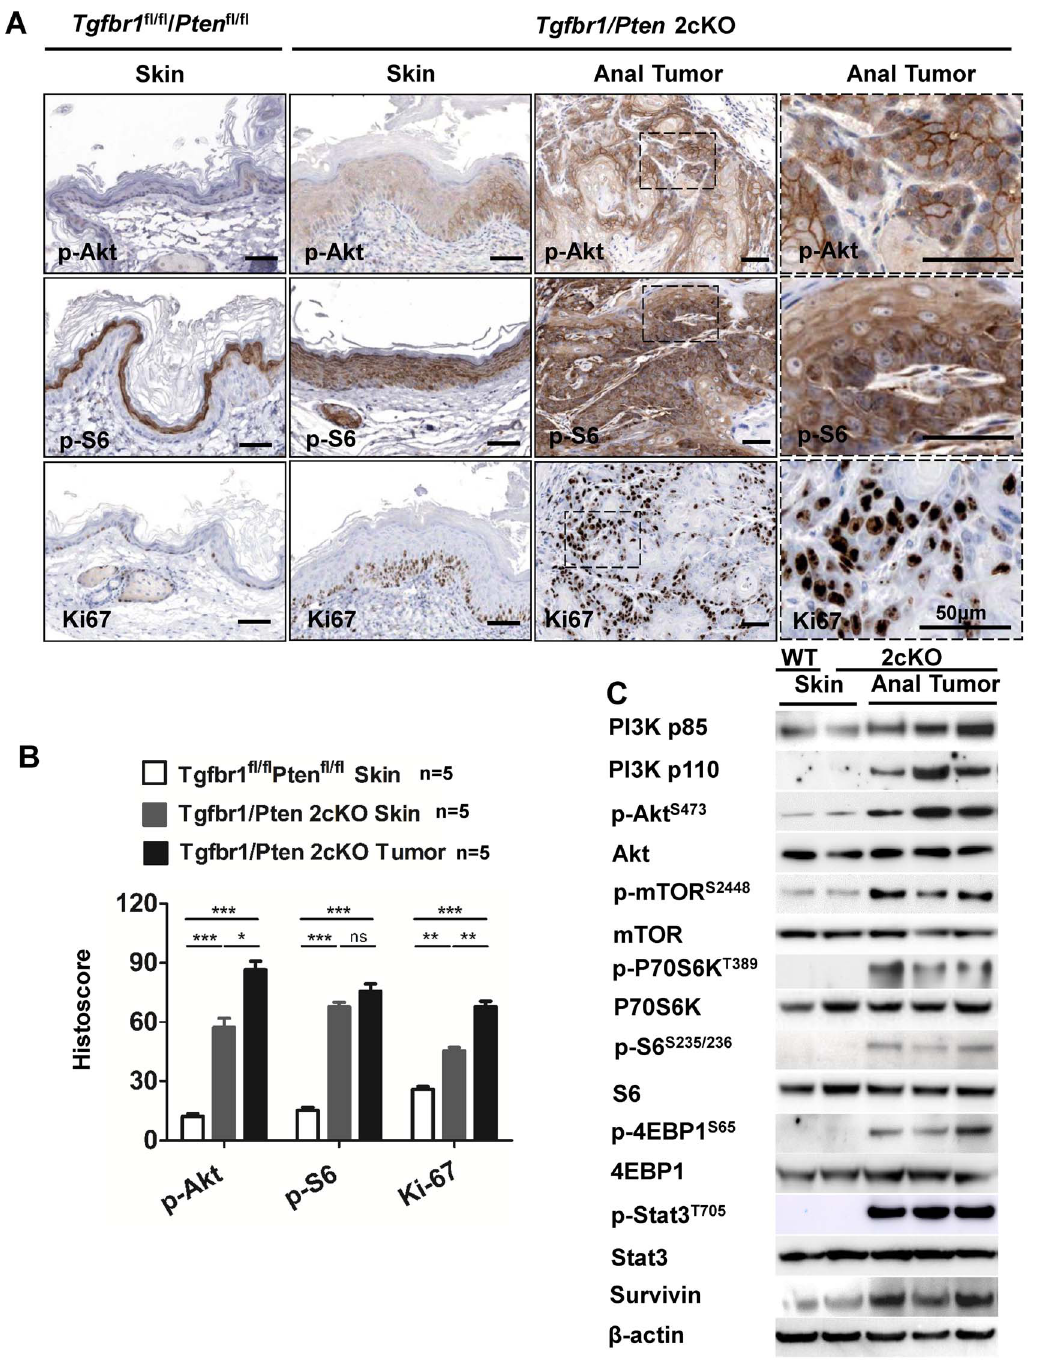
Figure 3. Activation of Akt/p-S6/Ki67 in Tgfbr1/Pten 2cKO ASCC. (A), immunostaining with specific antibodies indicates increased expression of p-Akt, p-S6, and Ki67 in Tgfbr1/Pten 2cKO mice ASCC (higher magnification is shown in the right most cloumn) as compared with Tgfbr1 flox/flox / Pten flox/flox skin (scale bars =50 m m). (B), the quantification of immunostaining shown in panel (A) presented as histoscore. Mean 6 SEM; *, P , 0.05; **, P , 0.01; ***, P , 0.001: One-way ANOVA. (C), Western blot analysis shows a significant increase in p-Akt, p-mTOR, p-P70S6K, p-S6, p-4E-BP1, and survivin in Tgfbr1/Pten 2cKO ASCC as compared with Tgfbr1 flox/flox /Pten flox/flox anal skin. The total protein of Akt, P0S6K and S6 remain unchanged.